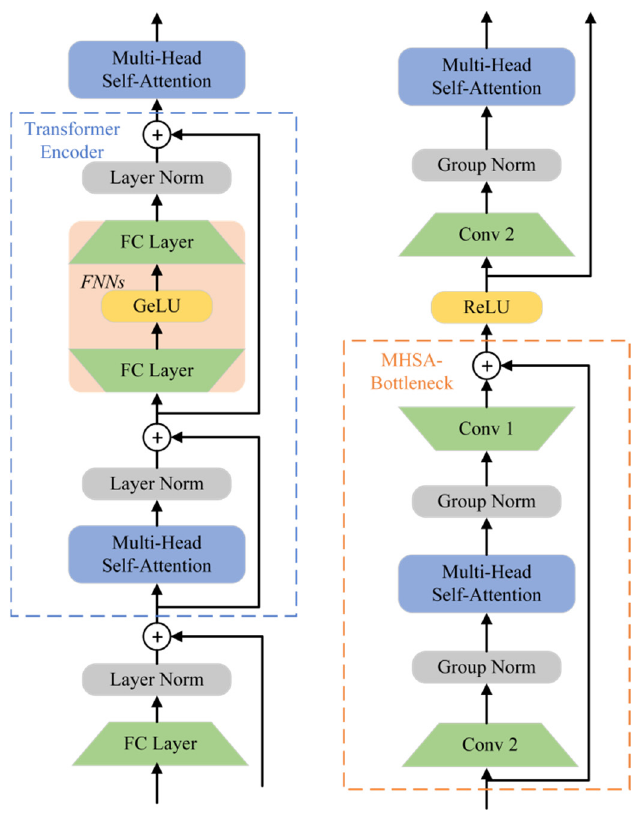
Figure 5. The detailed architecture of Transformer encoders and MHSA-Bottlenecks. MHSA-Bottlenecks have almost the same type of components as Transformer encoders.